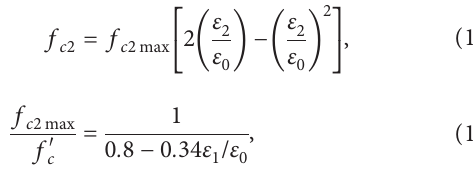
Softened concrete